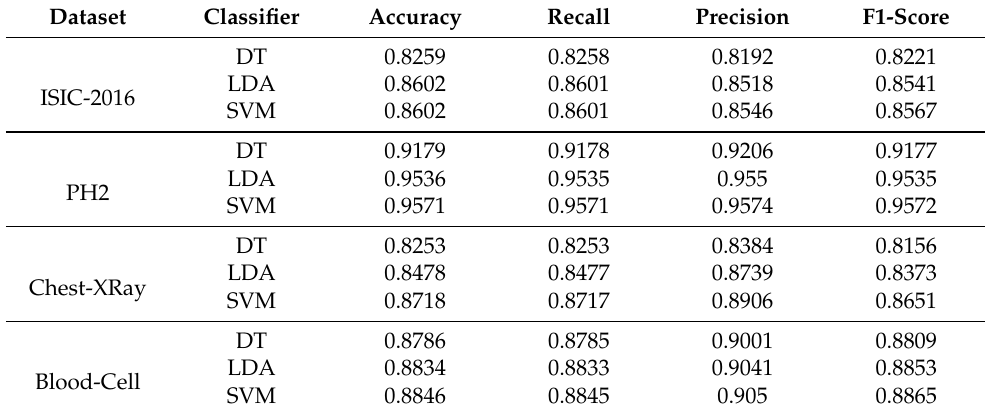
Table 3. Classification results without using feature selection